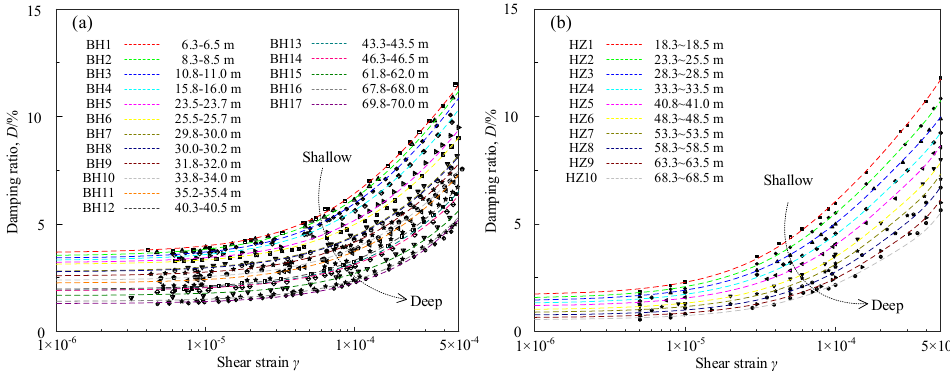
Figure 11. Comparison of measured values and predicted D – γ curves for marine clays from ( a ) Bohai Bay; ( b ) Hangzhou Bay.